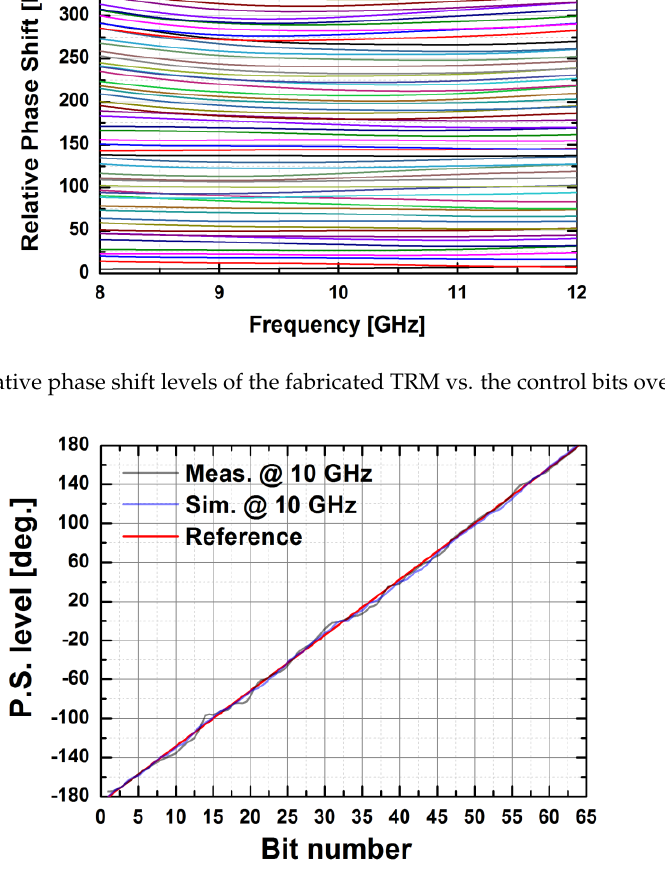
Figure 25. The measured phase shift levels vs. ideal values at 10 GHz as a function the control bits.